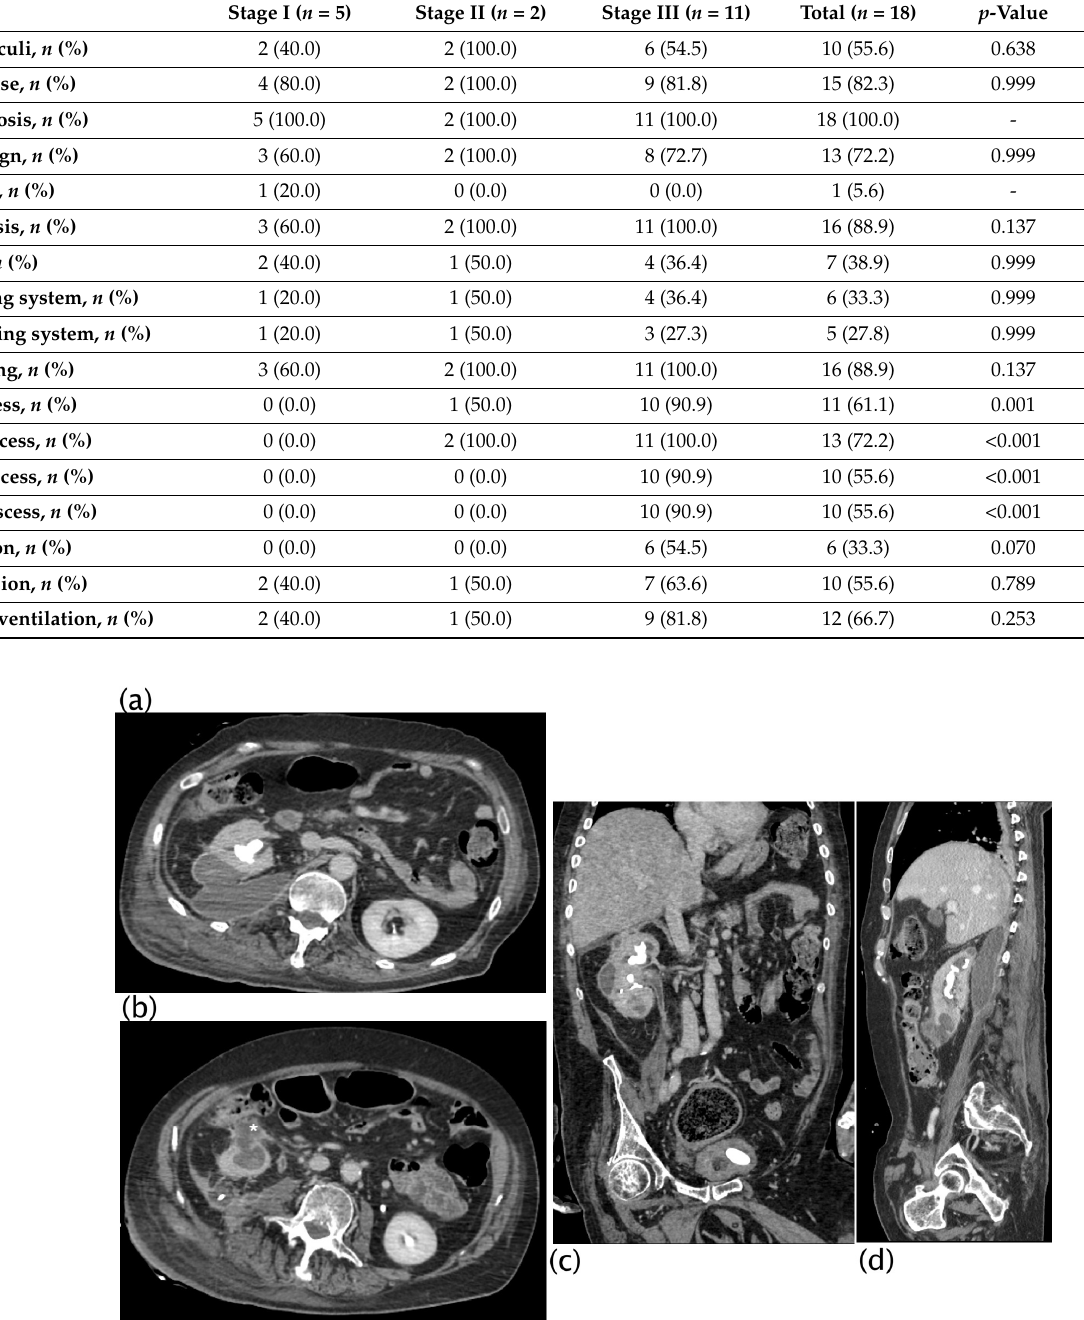
Table 4. CT findings in stages of XGP. Table 4. CT fi ndings in stages of XGP.